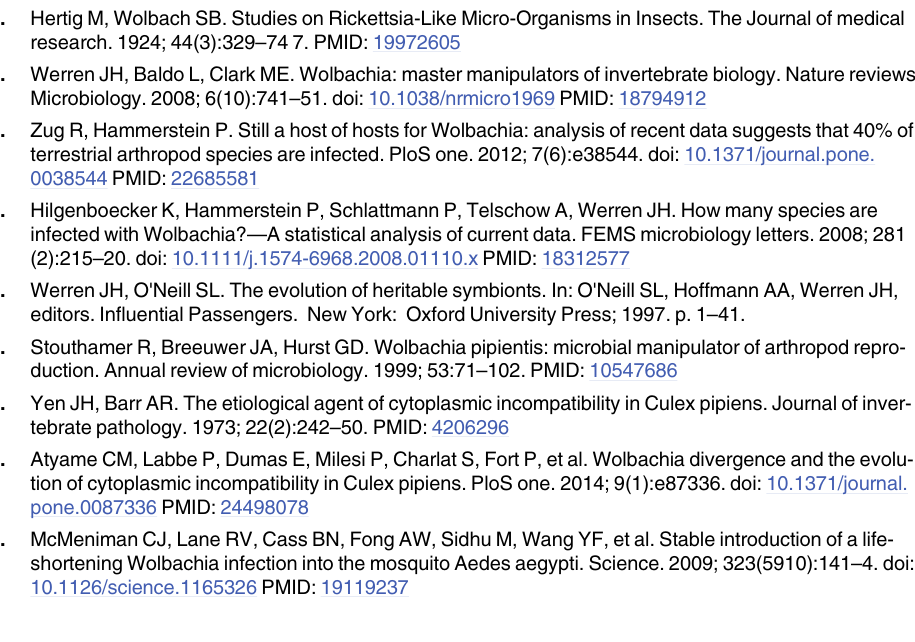
S1 Table. Baseline patient characteristics for the 41 successful infectious feeds performed using viremic human blood. S2 Table. Marginal multiple linear regression models for viral load (log10 copies/ml) in abdomens and salivary glands depending on covariates. Only infected abdomen or salivary glands were included. Results indicate that both Wolbachia strains significantly reduce the concentration of DENV in respective infected tissues. Coef = Regression coefficients, CI = Confidence intervals, WT = Wild type, (cid:3) = p < 0.05, (cid:3)(cid:3) = p < 0.01, (cid:3)(cid:3)(cid:3) = p < 0.001. # Com- parison between w Mel and w Mel w AlbB give coefficients of -0.147 (95% CI -0.549 to 0.255, p = 0.474) for abdomen and -1.546 (95% CI = -1.848 to -1.245, p < 0.001) for salivary glands, indicating lower viral loads in salivary glands of w Mel w AlbB infected females compared to the w Mel